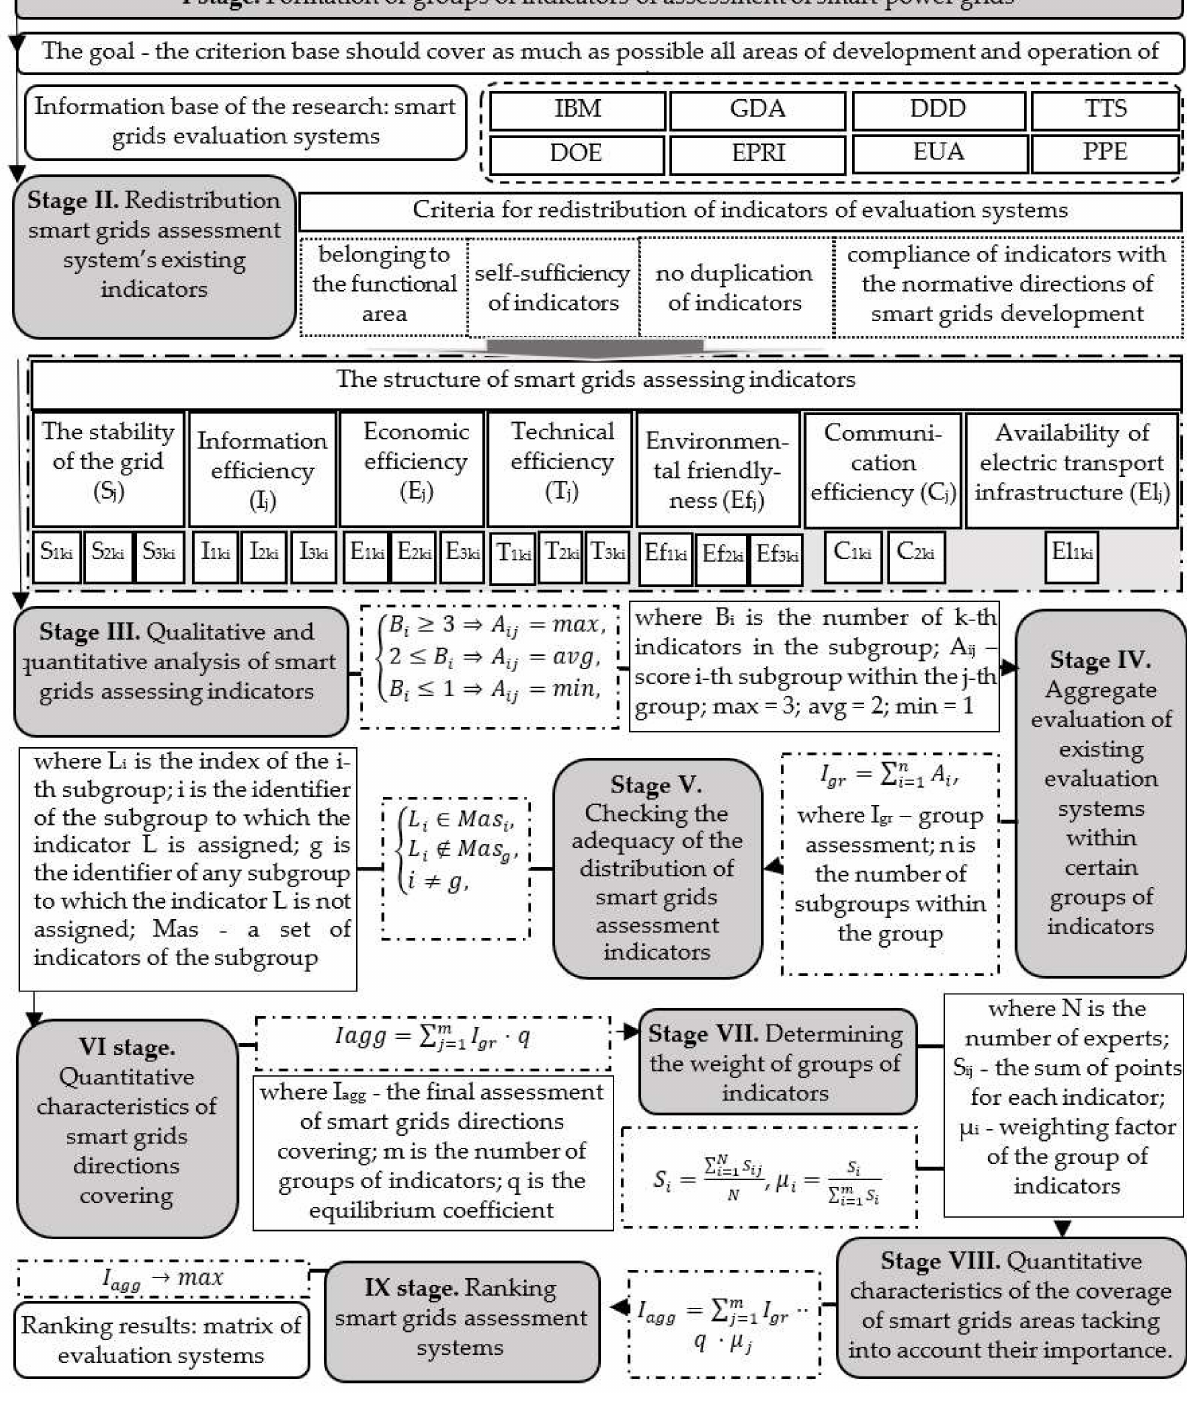
Figure 1. Methodological tools of comparative analysis of smart grids comprehensive assessment systems. S 1ki —System